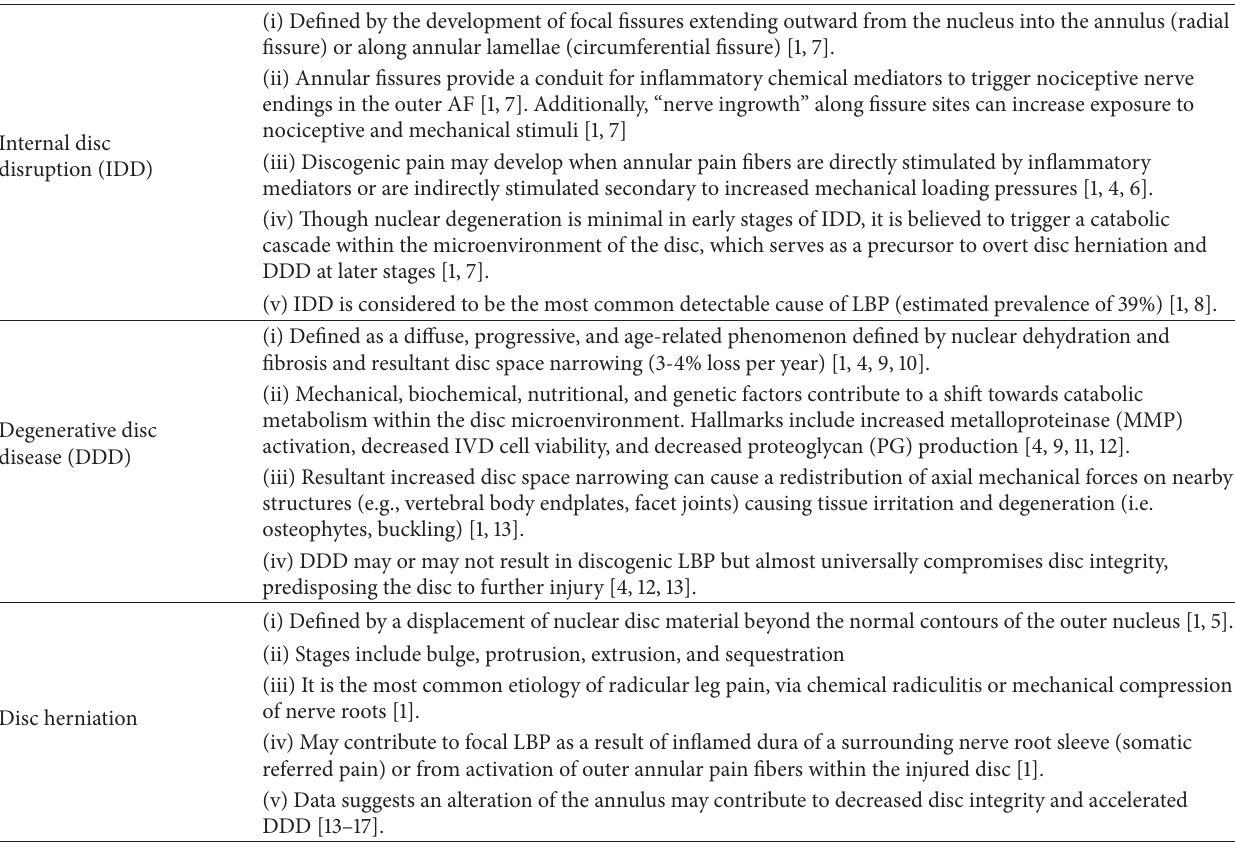
Table 1: Intervertebral disc